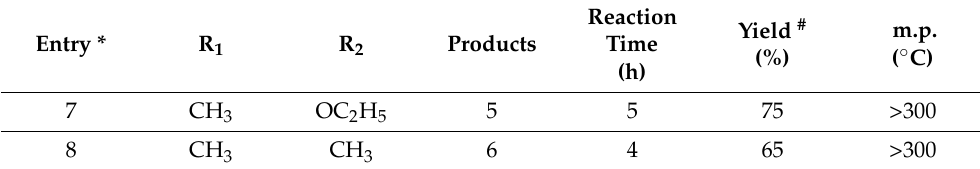
Table 2. Synthesis of bis-3,4-dihydropyrimidin-2( 1H )-one.